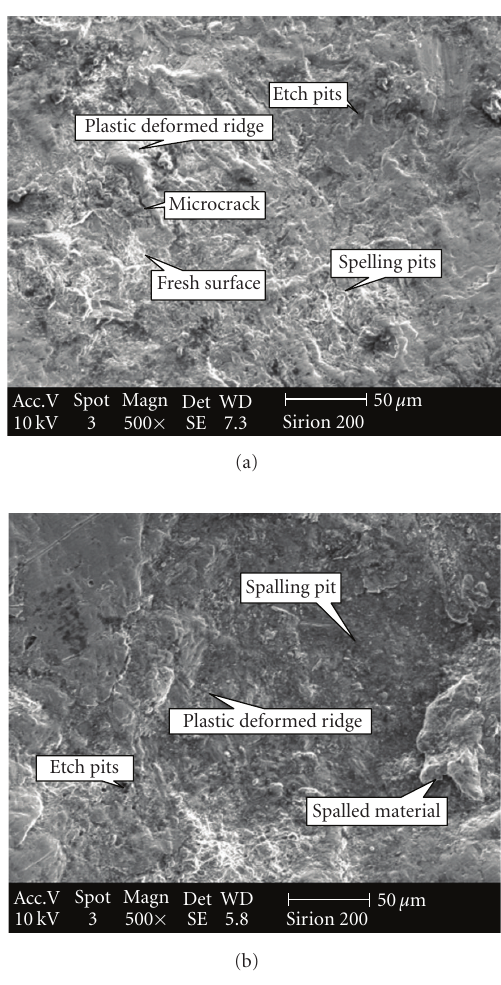
Figure 6: Worn surface morphology after impact-corrosion wear for 8 hours and 16 hours at the impact energy of